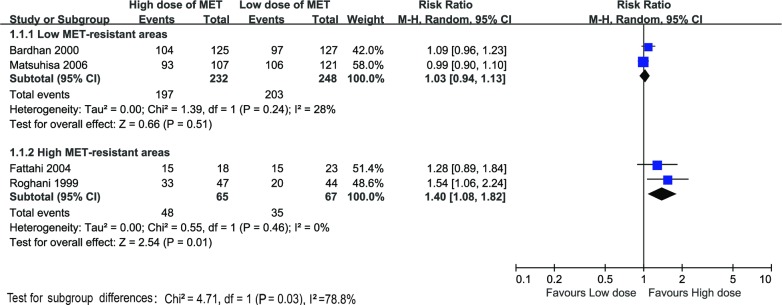
Forest plot of H. pylori eradication rate with high-dose therapies compared to low-dose therapies in the areas with high vs. low metronidazole resistance.A. Comparison of the high-dose therapies with low-dose therapies in low metronidazole-resistant areas. B. Comparison of the high-dose therapies with low-dose therapies in high metronidazole-resistant areas.